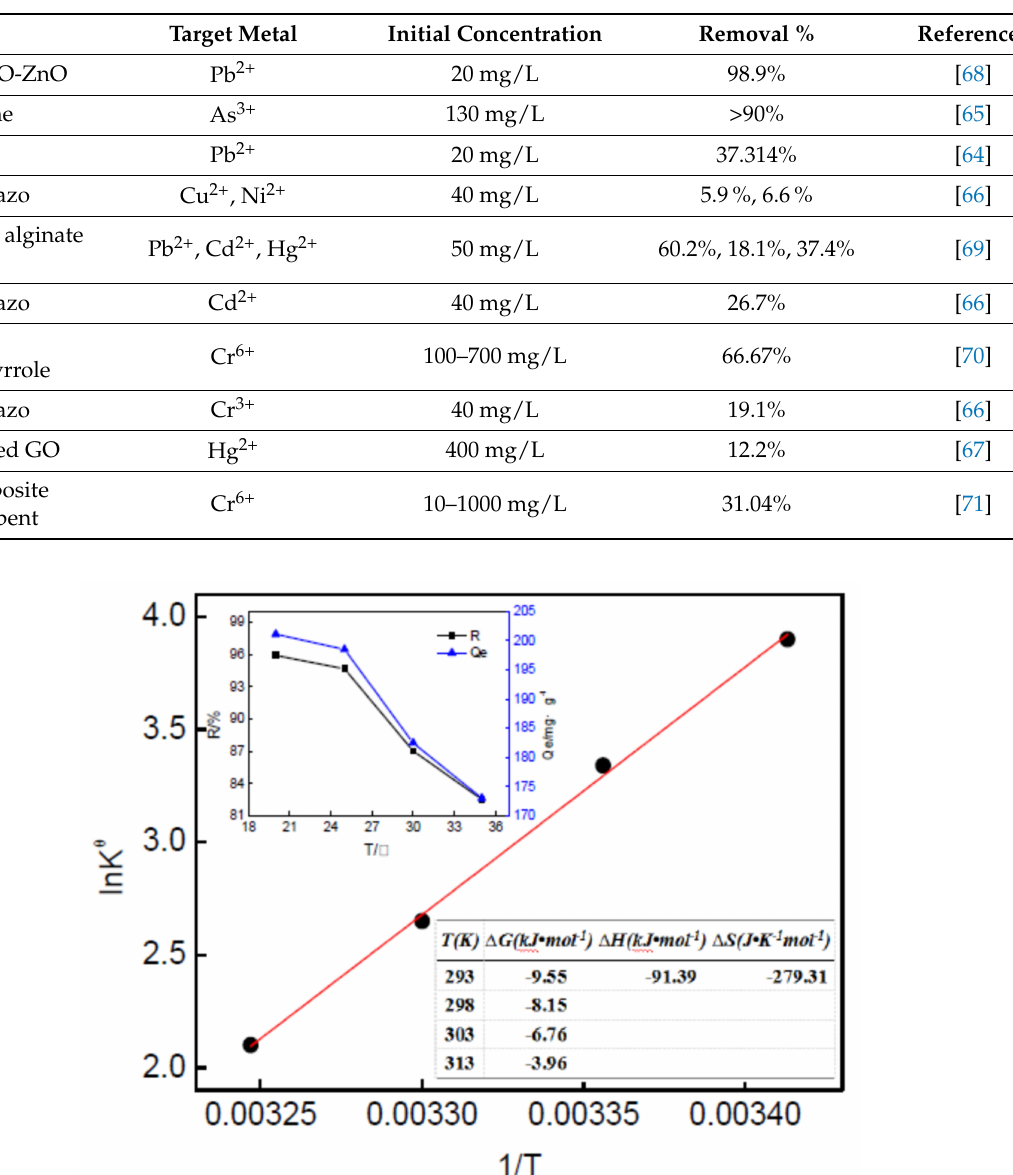
Table 3. Graphene derived nanoparticles for the removal of heavy metals.